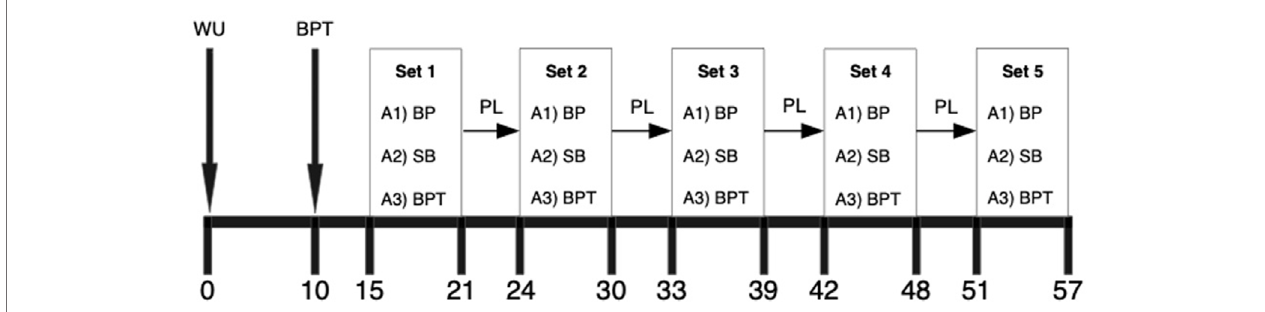
FIGURE 1 | Schematic representation of the experimental session including strength-power potentiating complexes with accessory exercises. WU, warm-up; BPT, bench press throw; BP, bench press; SB, swiss ball leg curls; PL, plank.